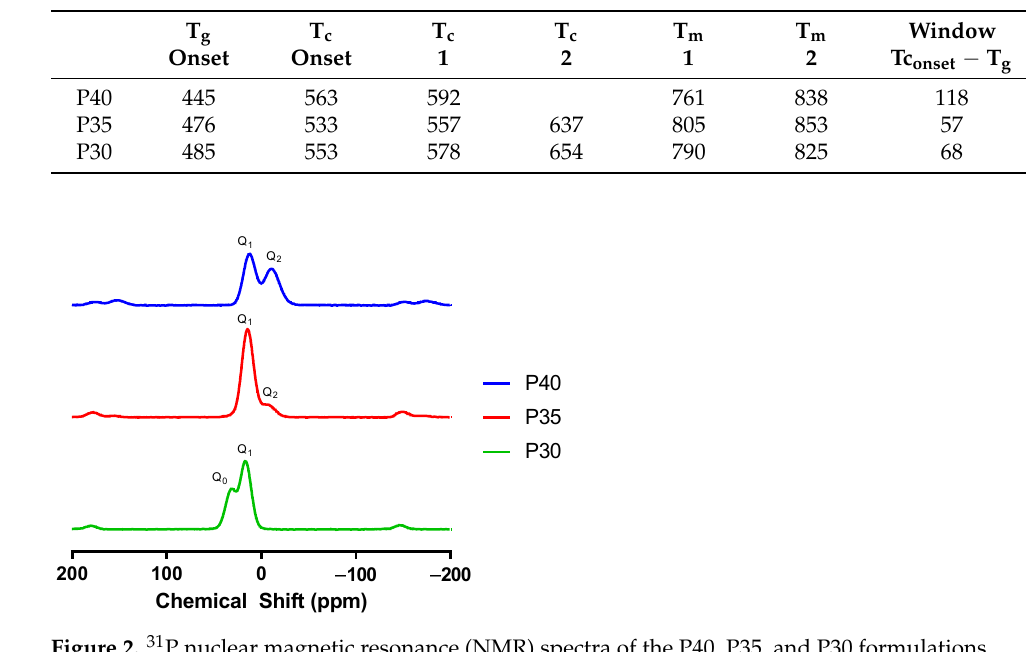
Figure 2. 31 P nuclear magnetic resonance (NMR) spectra of the P40, P35, and P30 formulations. P35 also demonstrated similar peaks identified as Q 1 (7.4 ppm) and Q 2 ( − 21.3 ppm) units. The slight shift in peaks associated with the Q 2 species was suggested to be due to substitution of 5 mol% phosphate for calcium and a decrease in Q 2 species content from 49% to 6% followed by equivalent increases in Q 1 species from 51% to 94%. When the level of phosphate content was further decreased to 30 mol% in the P30 formulation, a shift from Q 2 and Q 1 to Q 0 (3.3 ppm) fractions was observed, indicating presence of orthophosphate content, which was absent from the other two formulations explored revealing a Q 1 to Q 0 ratio of 61% and 39%, respectively (Table 3). Table 3. Distribution of Q n species across PBG